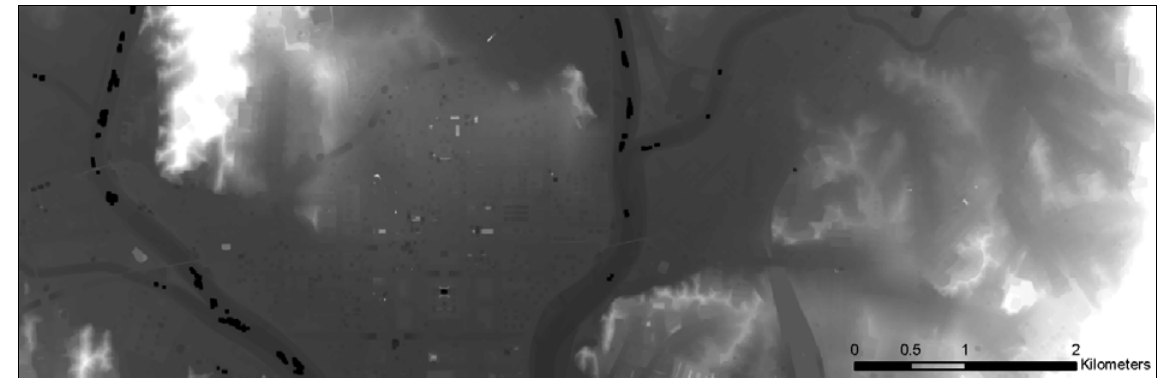
Figure 15. DTM filtered from DSM produced from dataset